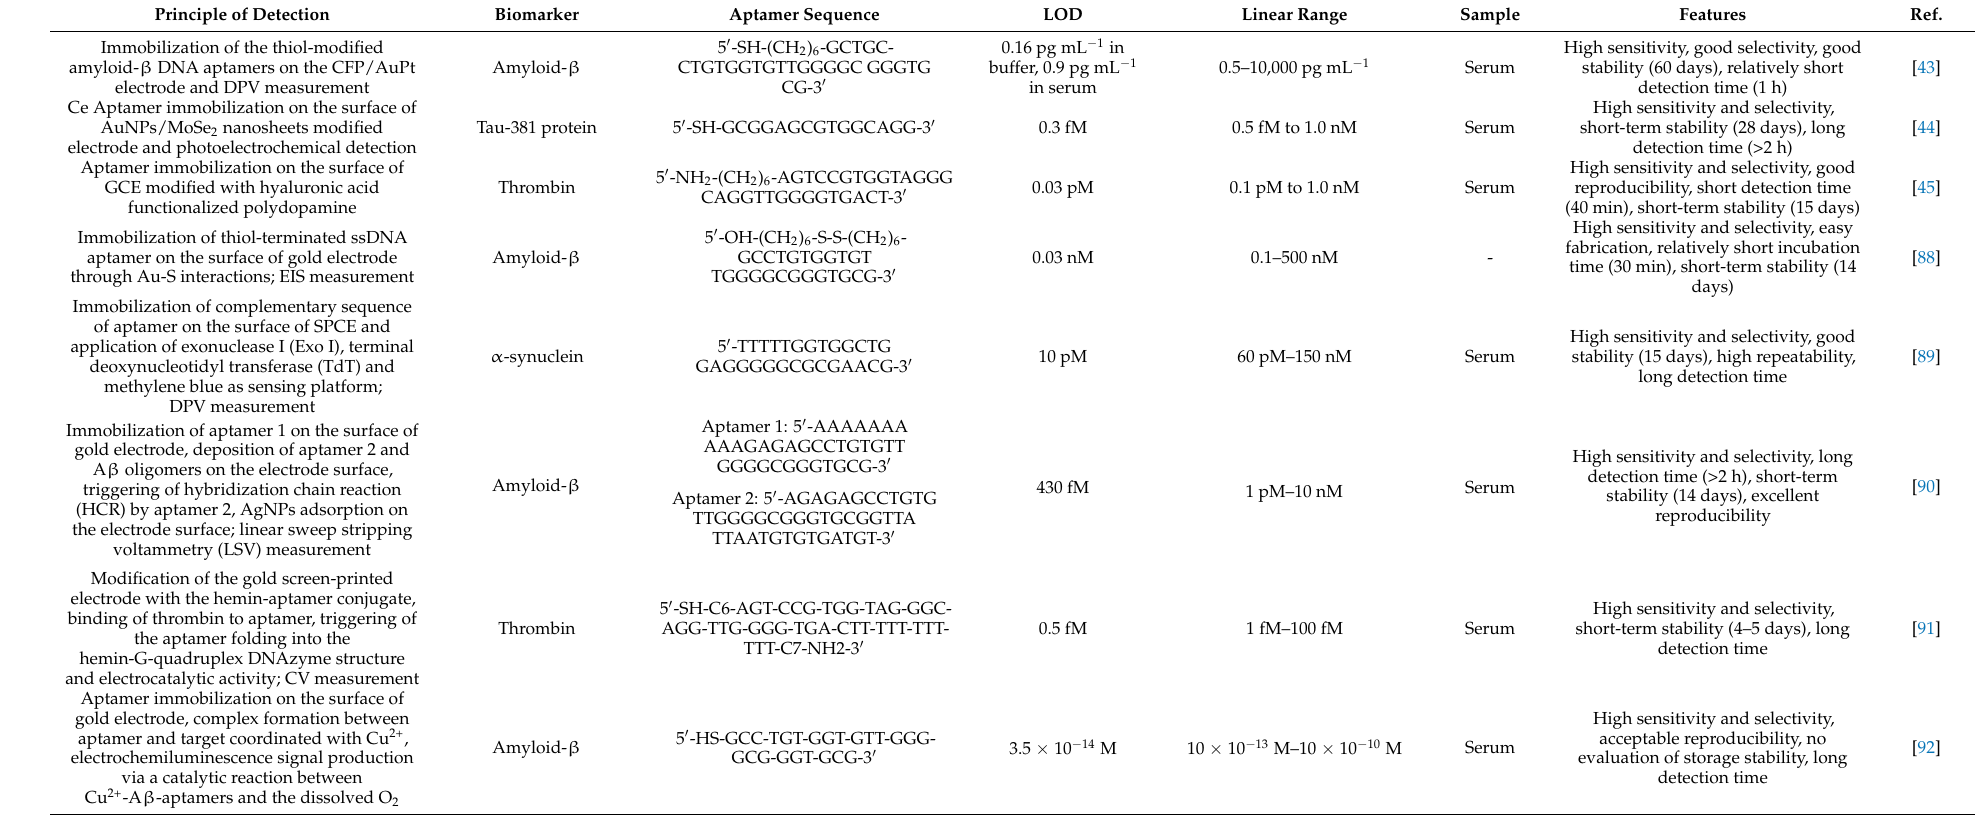
Table 3. Recent advances in electrochemical aptasensors for the detection of Alzheimer’s disease